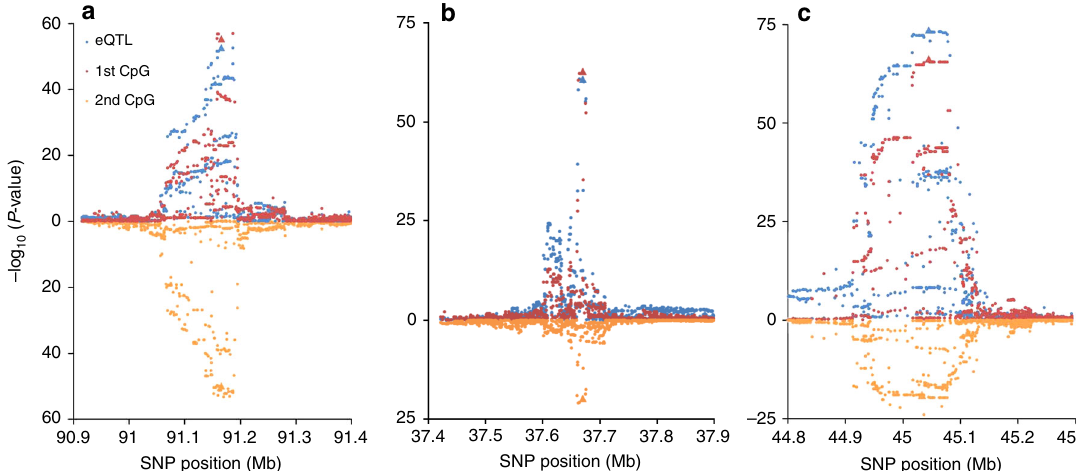
Fig. 7 Examples of eQTLs that co-localize with a meQTL that has opposite effects on two nearby CpG sites. Results for the CpG selected for co-localization analysis (red) are shown on the top of each plot (ascending), overlaid with the eQTL results (blue). For these scenarios, the expression-increasing allele is associated with increased methylation at a "primary" CpG. Results for a “ secondary CpG ” are shown below (descending) in orange, for which the expression-increasing allele is associated with decreased methylation. The lead eSNP is shown as a triangle. a eSNP: 10:91186842, gene expression probe: ILMN_1696654, fi rst CpG: cg27582166, second CpG: cg13172359. b eSNP: 6:37669641, gene expression probe: ILMN_1720595, fi rst CpG: